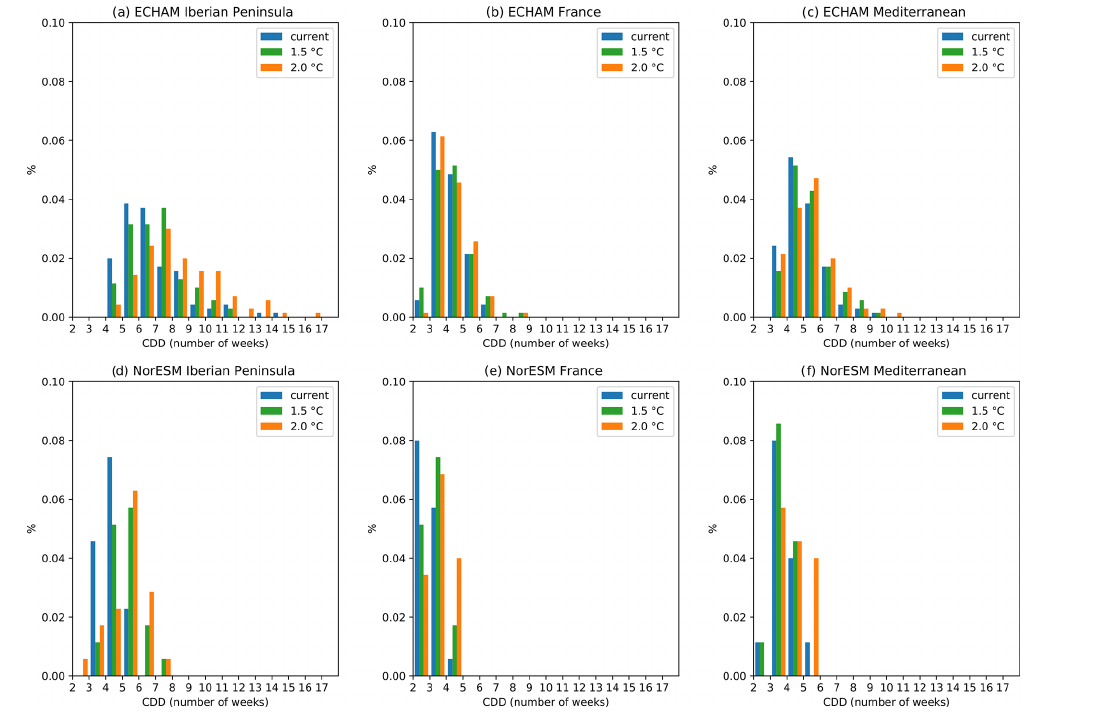
Figure 6. Duration of drought events in three PRUDENCE regions (Iberian Peninsula, France, and the Mediterranean) under 1.5 and 2.0 ◦ global warming for the ECHAM-driven (a–c) and NorESM-driven (d–f) ensembles. For significance see Table